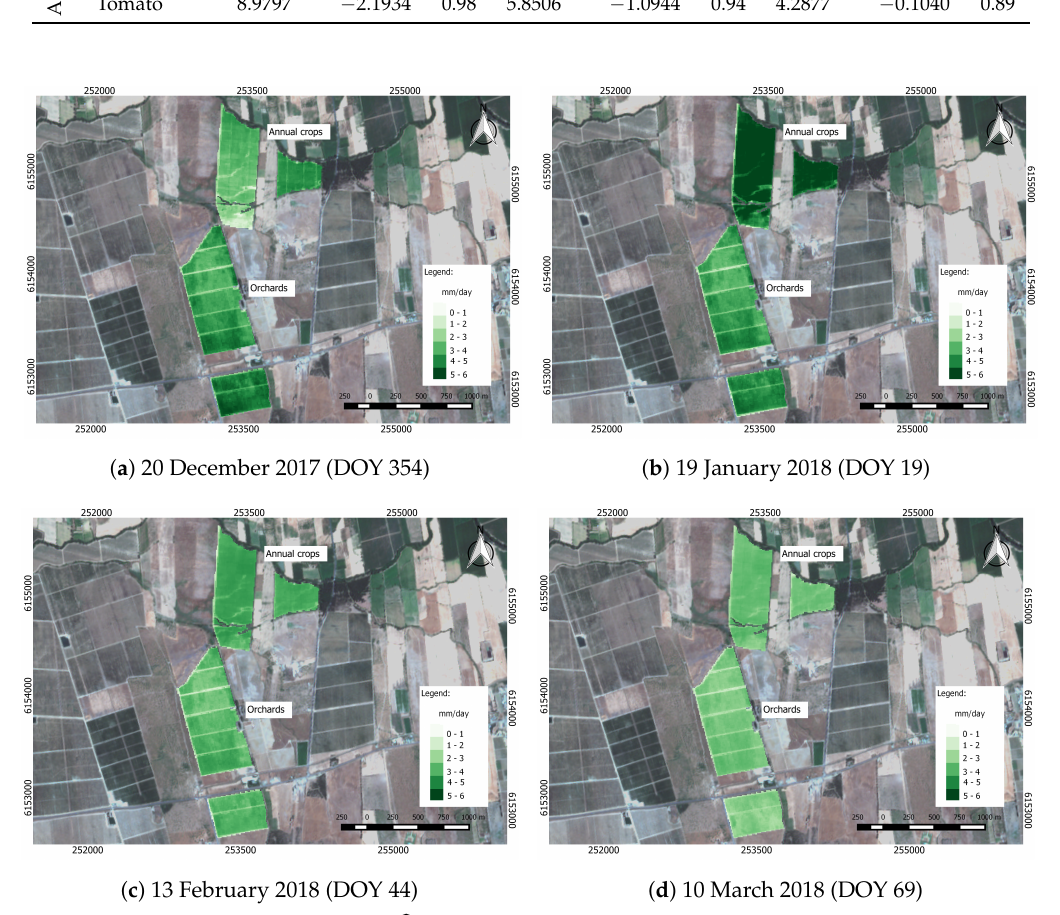
Figure 6. Daily evapotranspiration ( (cid:99) ET ) maps for the four months of the growing season (December 2017 to March 2018), for the agricultural cover of the study area. Annual crops, industrial tomatoes, and orchards; plums are enlarged in the